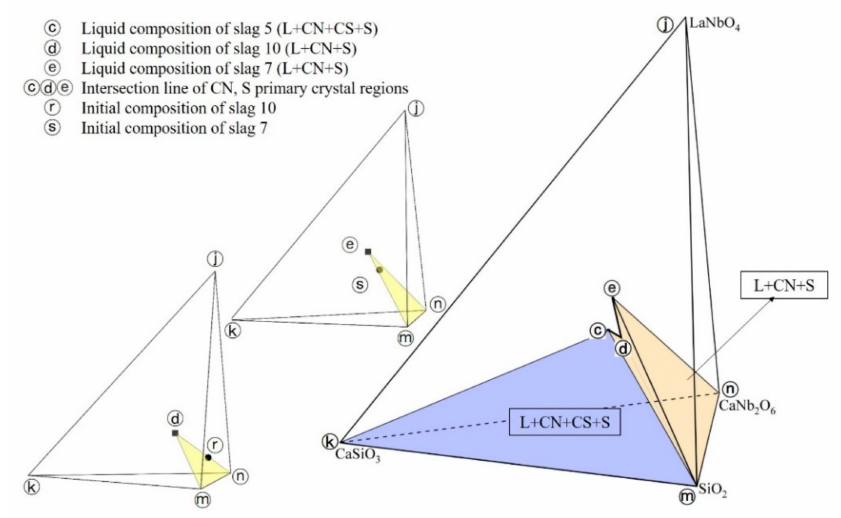
Figure 5. Intersection line of CN, S primary crystal regions.